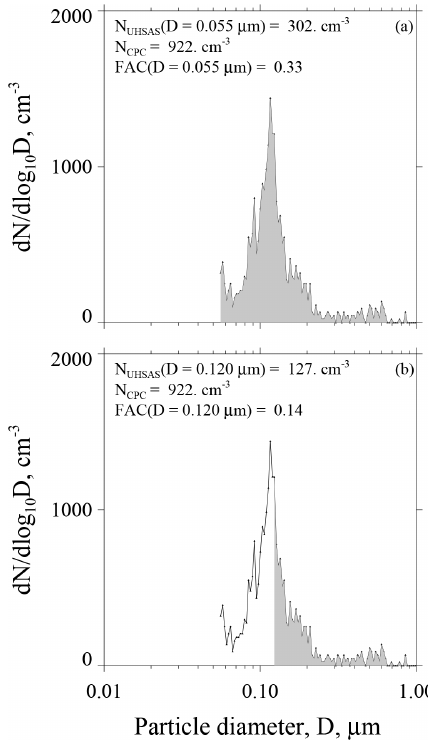
Figure 7. Two portrayals of the ASD recorded during CCOPE at 08:45:03UTC 5 June 2015. This ASD is also plotted in Fig. 4a. Gray area in both panels represents the aerosol concentration in- tegrated from the indicated lower-limit D to 1µm. (a) Figure leg- end has the size-integrated UHSAS concentration, calculated with lower-limit D set at 0.055µm, the CPC concentration, and the frac- tional aerosol concentration (FAC). (b) Figure legend has the size- integrated UHSAS concentration, calculated with lower-limit D in Eq. (2) set at 0.120µm, the CPC concentration, and the fractional aerosol concentration